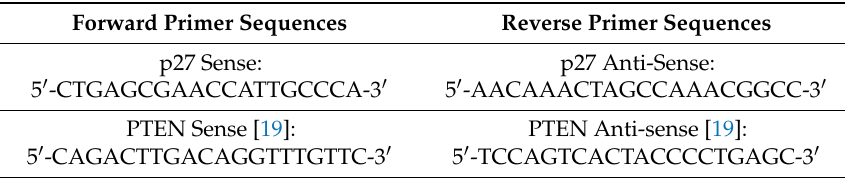
Table 2. ChIP qRT-PCR primer